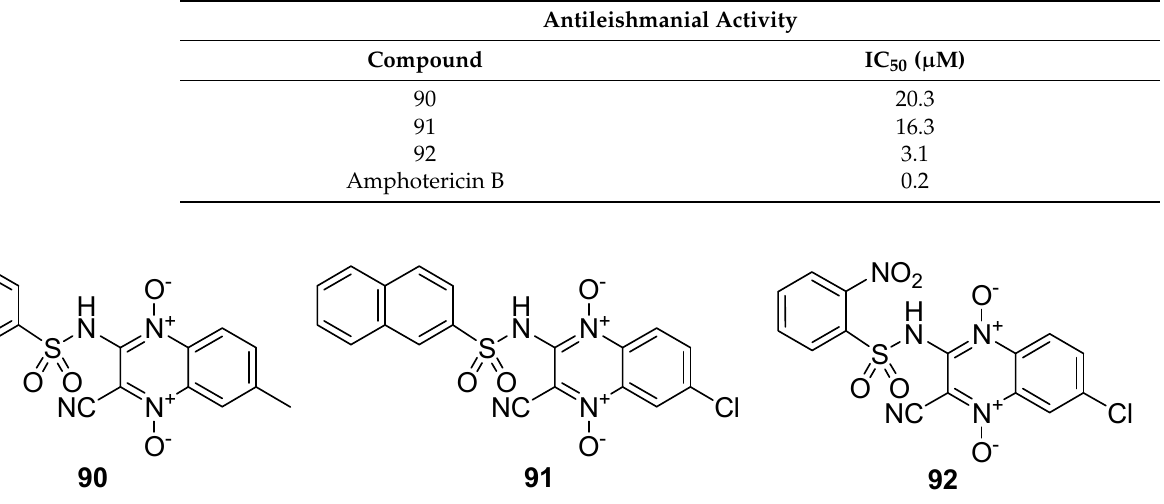
Figure 13. Structure of quinoxaline-1,4-dioxide sulfonamide derivatives 90–92 . Table 8. Antileishmanial activity of quinoxaline-1,4-dioxide sulfonamide derivatives 90–92.